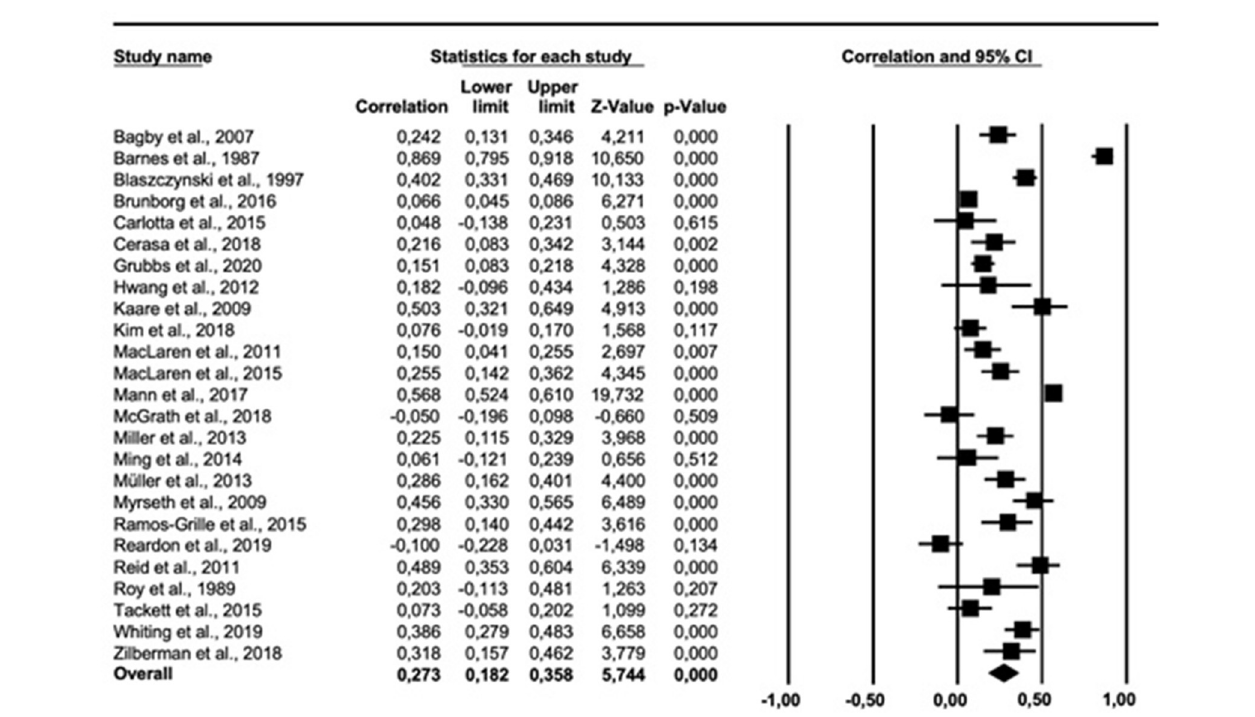
FIGURE 2 | Forest plot showing the relationship between gambling problems and neuroticism.